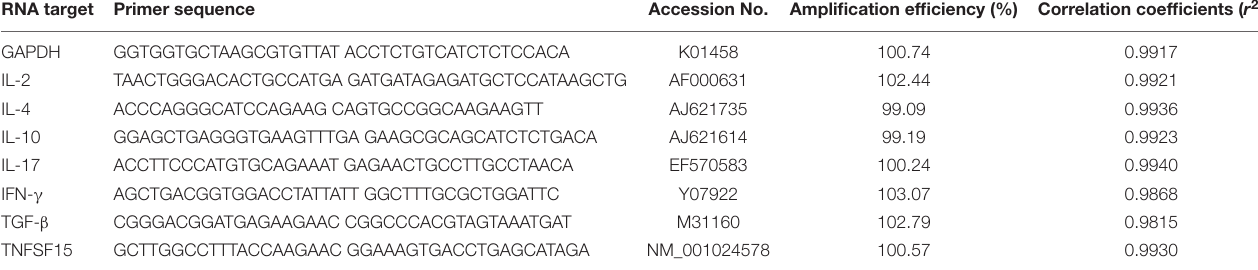
TABLE 1 | Primers used in